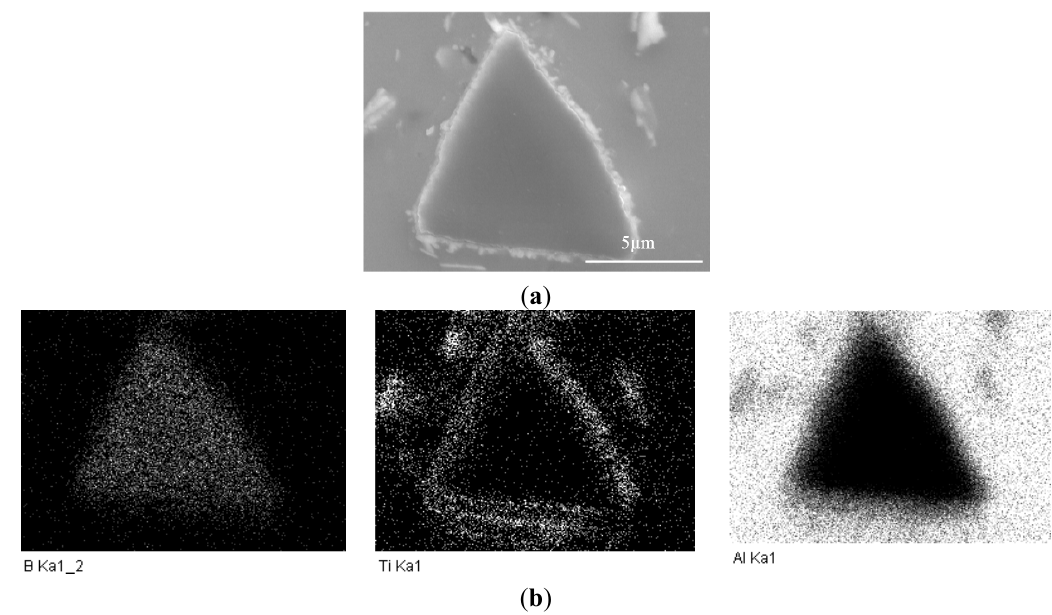
Figure 2. ( a ) SEM image of one B 4 C particle and ( b ) X-ray elemental mapping of ( a ) showing that B 4 C particles are protected by an in-situ TiB 2